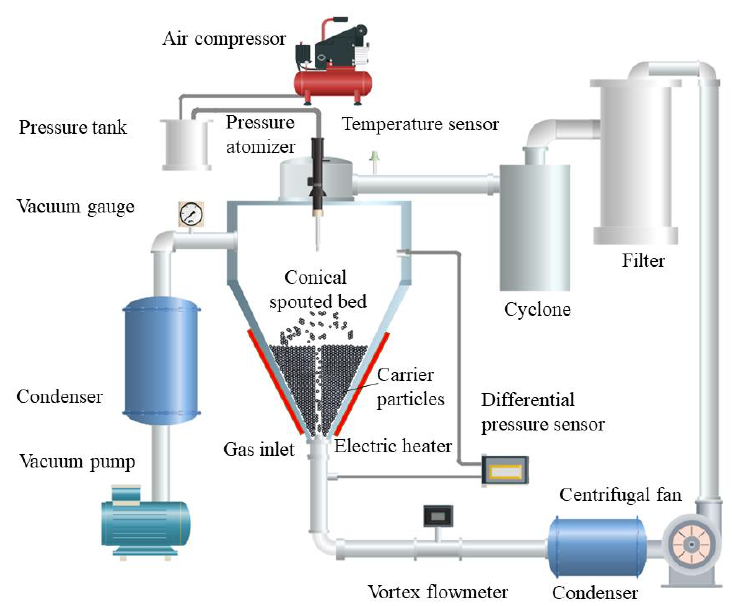
Figure 3. Flowchart of the carrier particle spouted bed for the spray freezing process [44].